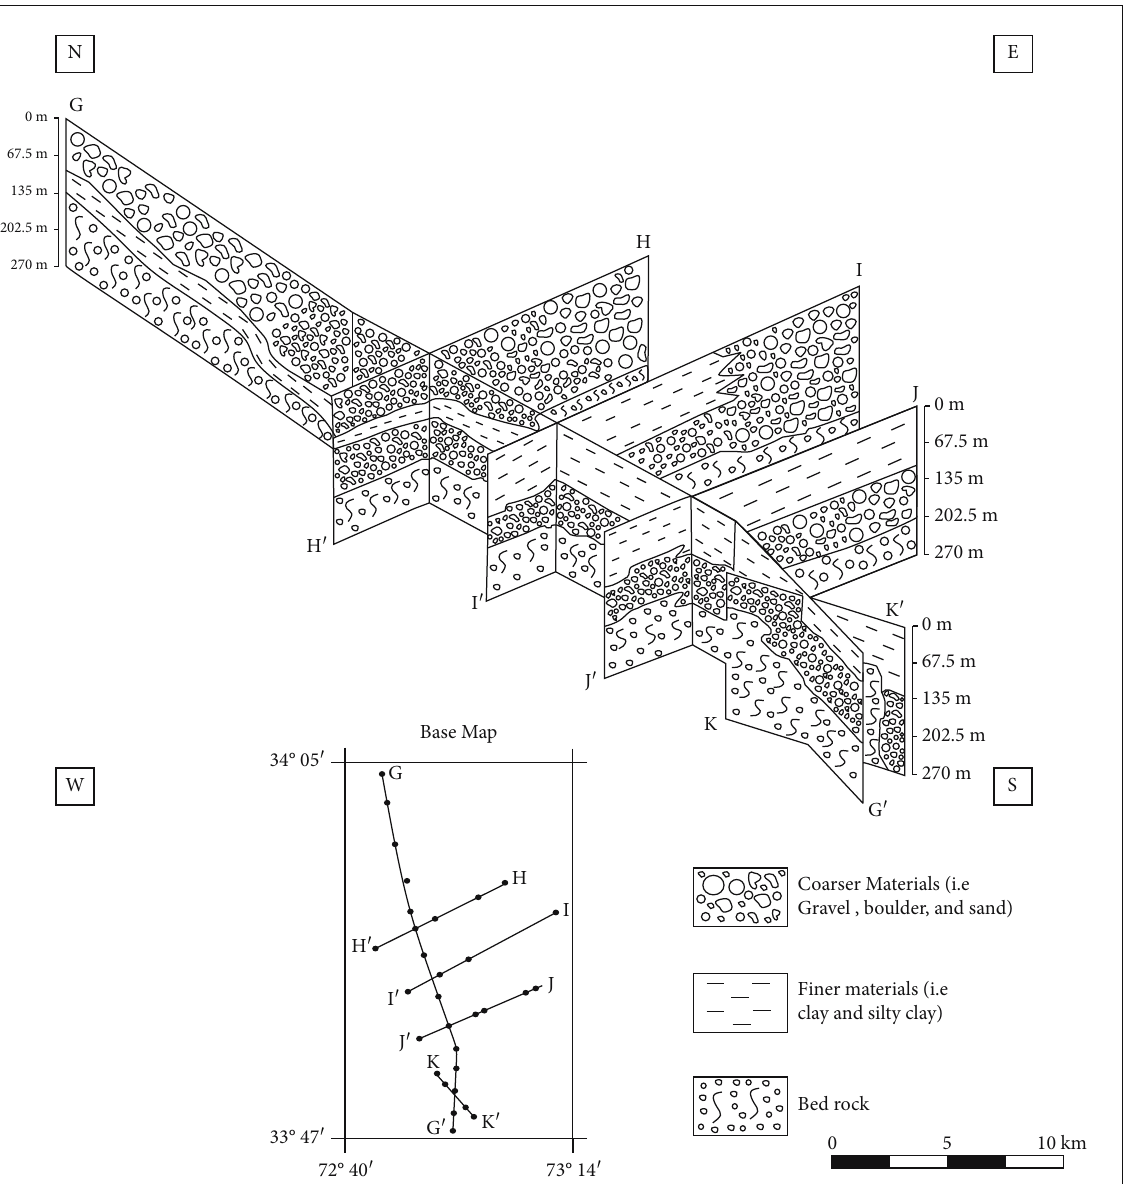
Figure 8: The alluvial architecture of the Haripur basin is represented by fence diagram. Relatively, coarser sediments dominate in the north and west; however, fi ner clays and silt are present in the center. The basemap represents generalized location of pro fi les that are integrated to generate the fence